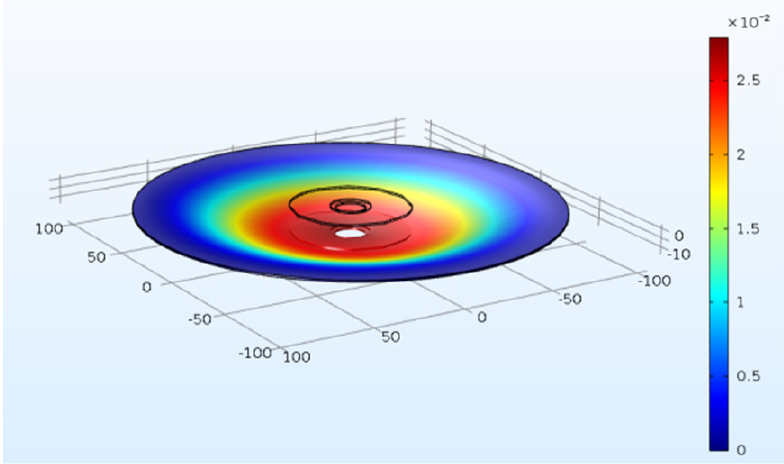
Figure 11. The stress contour of the PCDs.